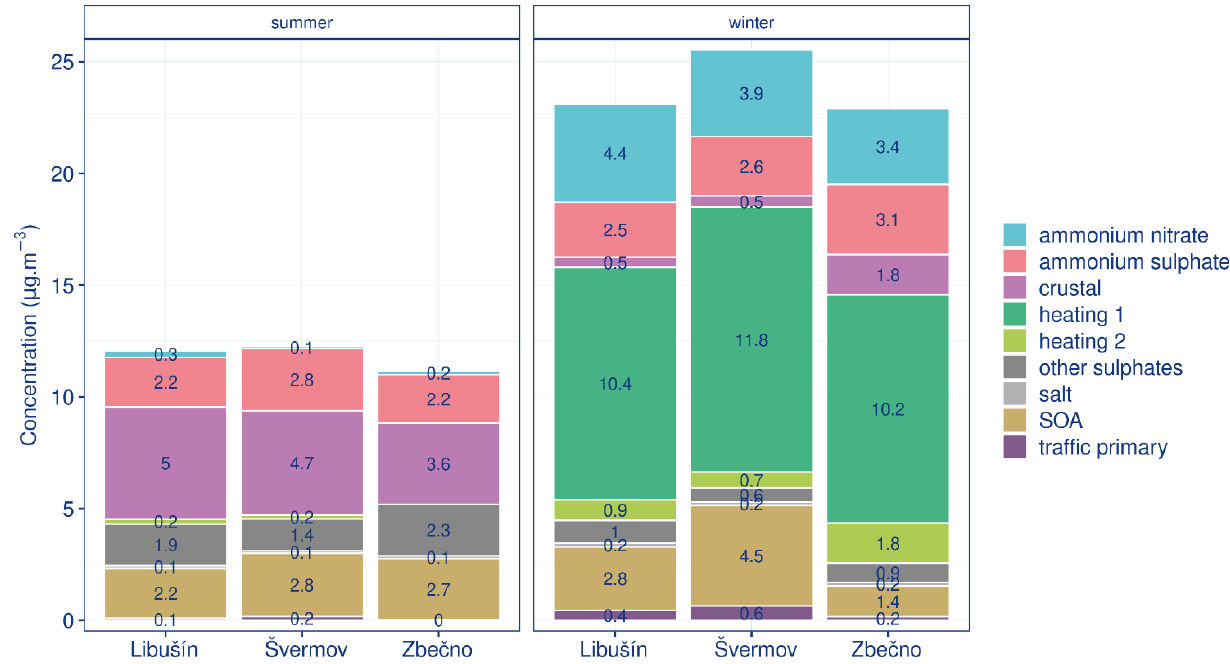
Figure 4. Factor absolute contribution to the PM 2.5 mass grouped by season and monitoring sites.